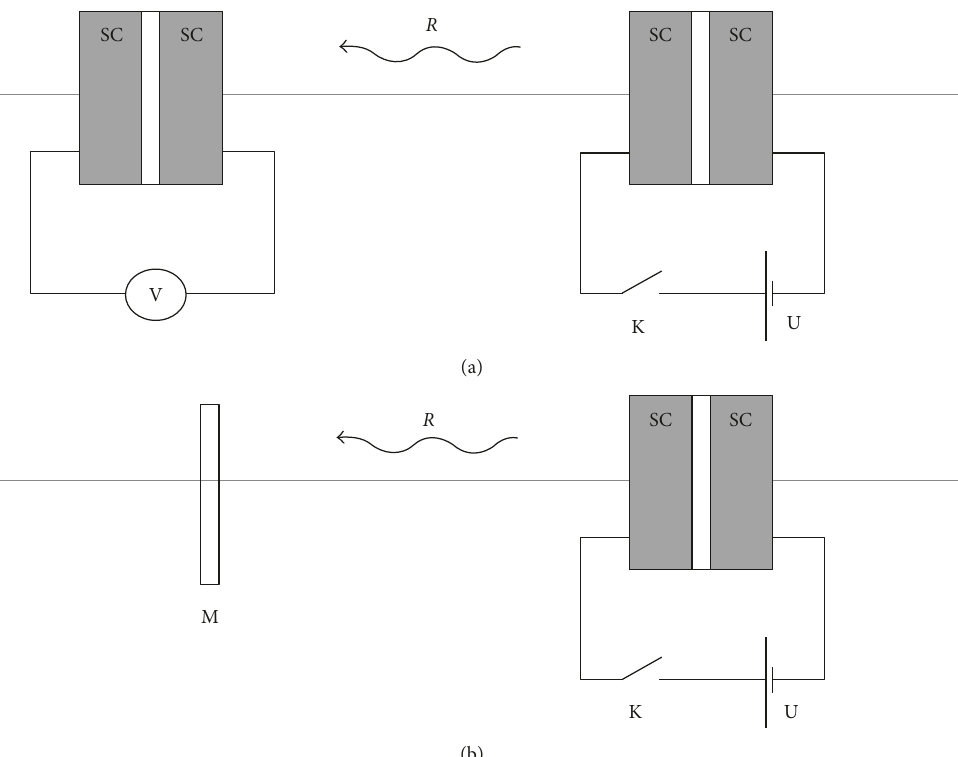
Figure 1: Detection schemes. (a) Detection based on the reversibility of the effect. Here a discharge with e.m.f. U is conducted in one of the junctions as the circuit is closed via key K. The emitted geometric field 𝑅 is detected with the second Josephson junction with the voltage induced between its sides as the geometric pulse impinge on it. (b) Detection based on the dislocation induced by the geometric pulse 𝑅 on a mirror M part of an interferometer measurement